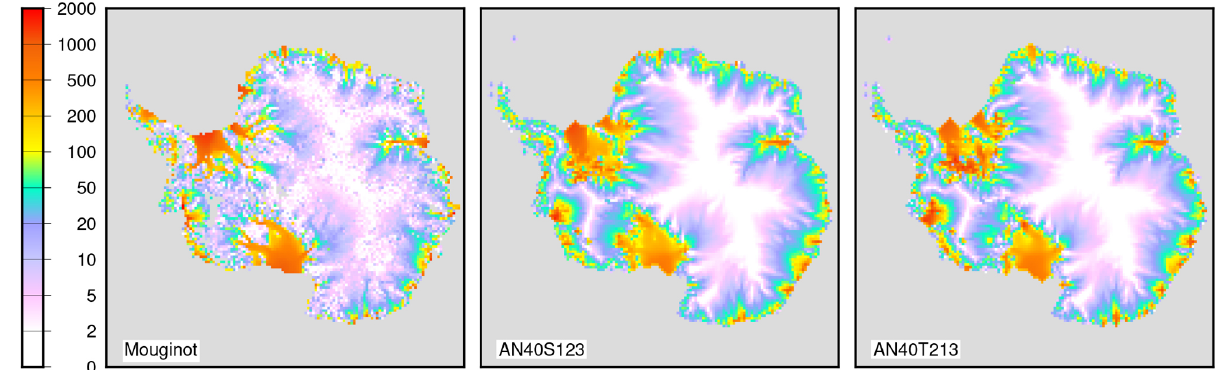
Figure 12. Map of observed (Mouginot et al., 2017) and simulated velocities in myr − 1 for the ensemble members with the lowest RMSE using Schoof (2007) (AN40S123) and Tsai et al. (2015) (AN40T213).